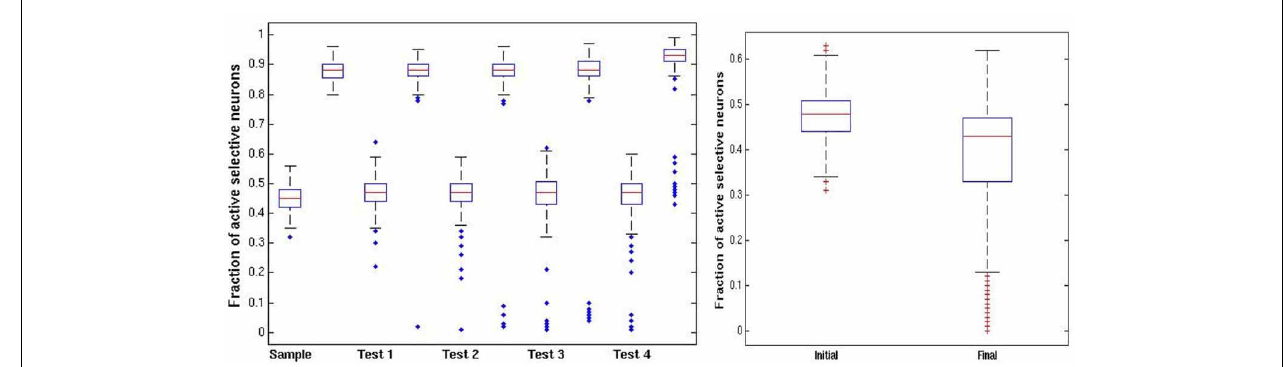
FIGURE 4 | DMS trials. Left panel: distribution of fraction of active selective units for the sample (first) image at each stage of the trial (100 simulations). Each stage shows a pair of boxplots. The first shows the resulting activity after the network is run in the high noise regime p fire = 0 . 45. The second shows the resulting activity after the low noise